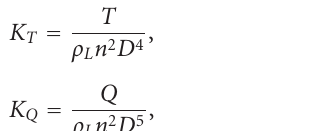
Figure 9: PPTC, computational domain.